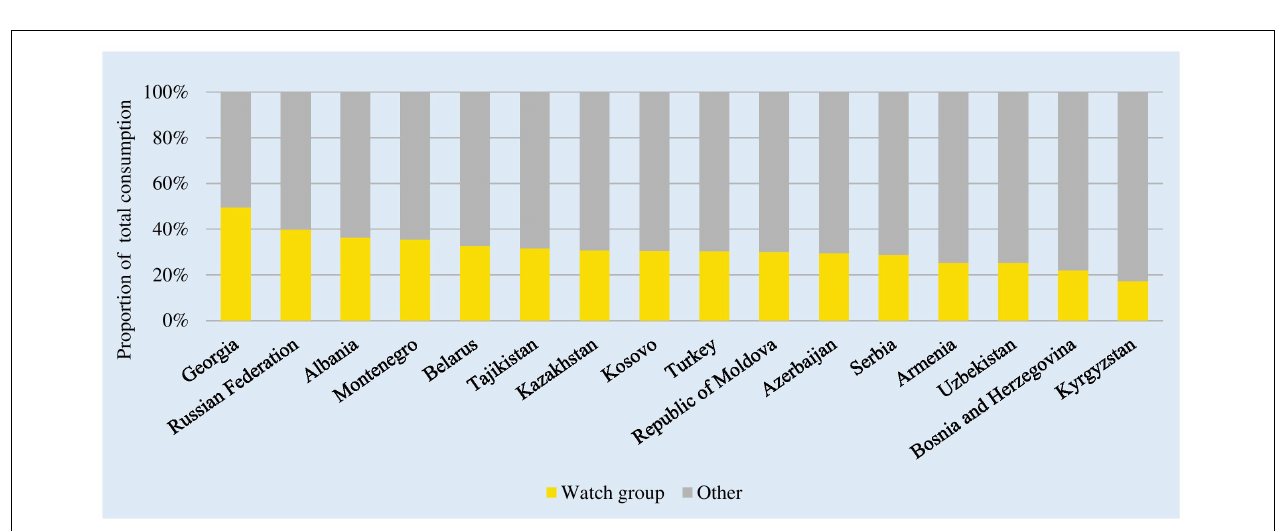
FIGURE 3 | Relative consumption of cephalosporins by generation of agents, 2015. ∗ Kosovo [in accordance with United Nations Security Council resolution 1244 (1999)].